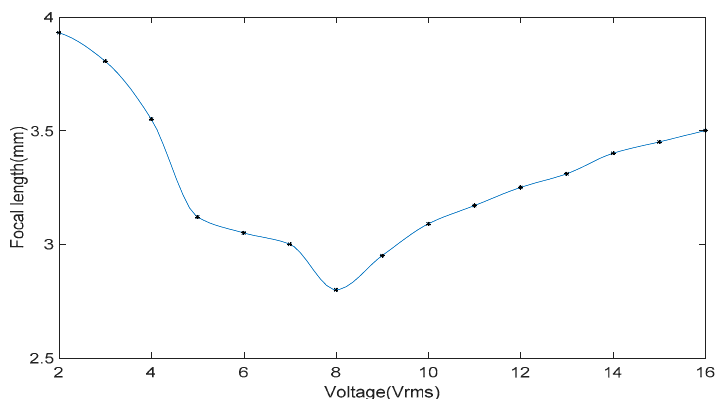
Figure 5. The relationship between the focal length of the dual-mode LC micro-device and the signal voltage applied.